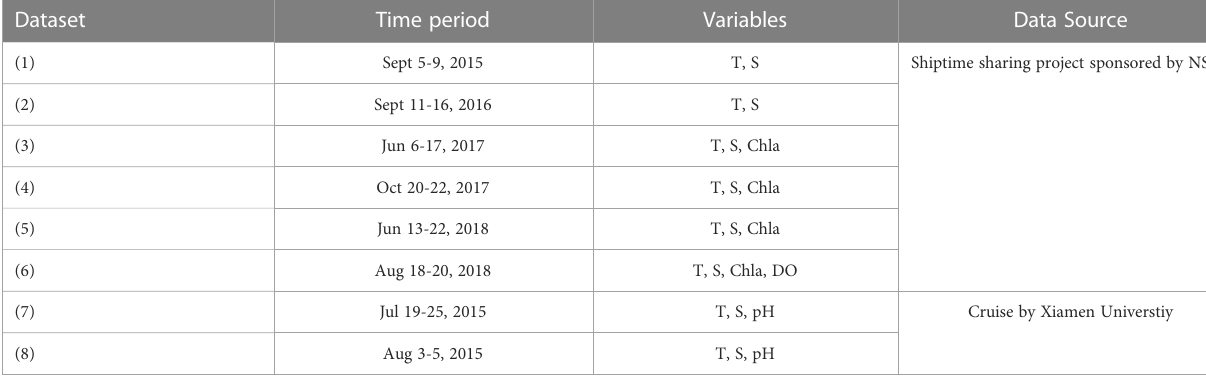
TABLE 2 The survey time and variables of datasets 1 – 8 from the cruises.